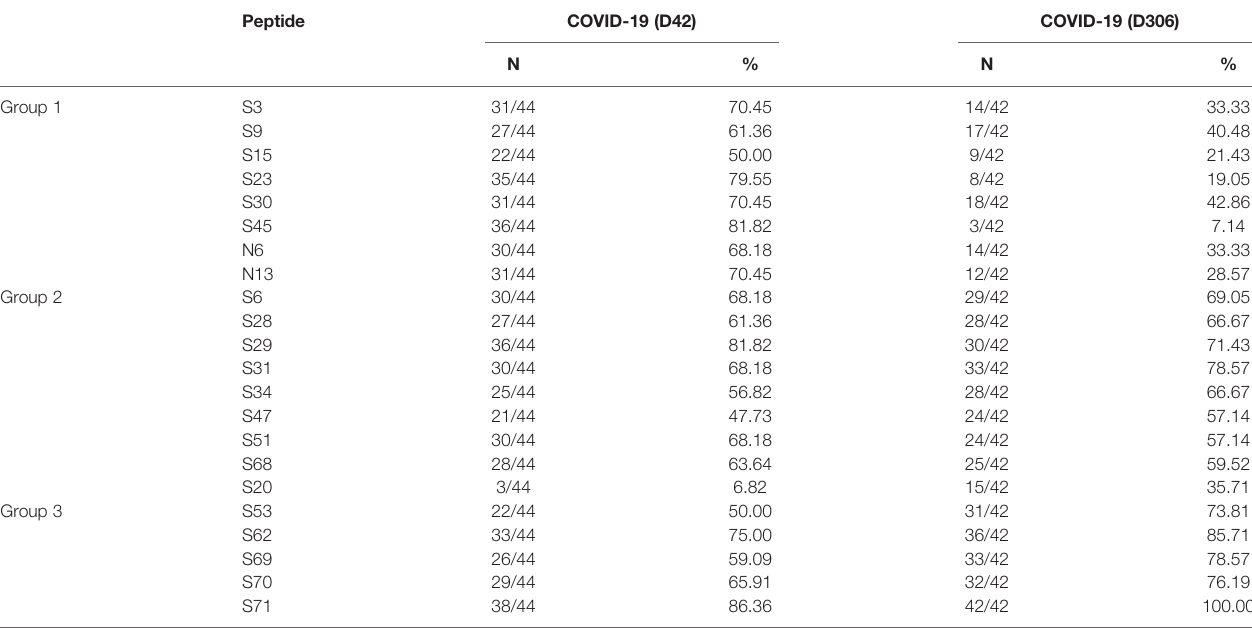
TABLE 2 | Analysis of longitudinal reactivity of COVID-19 serum with SARS-CoV-2 S and N protein peptides.